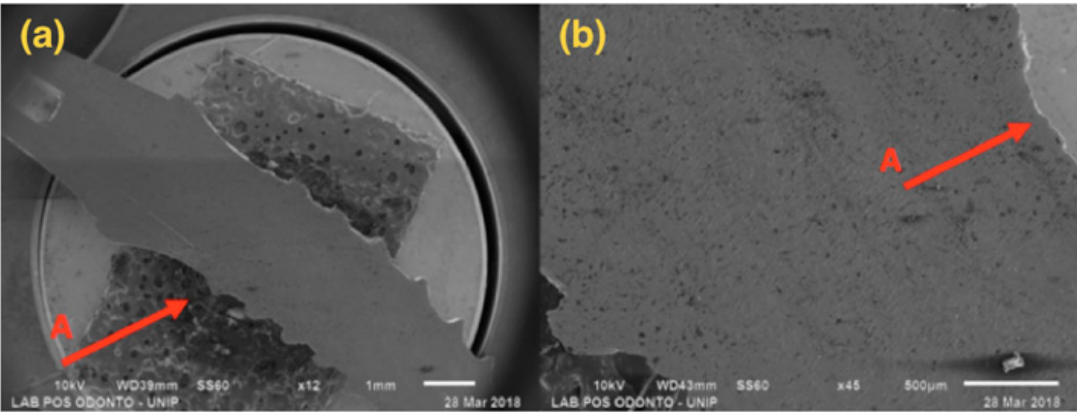
Figure 4. G1: Photomicrography: ( a ) Magnification of 12 × ; ( b ) Magnification of 45 × ; A—Distortion is